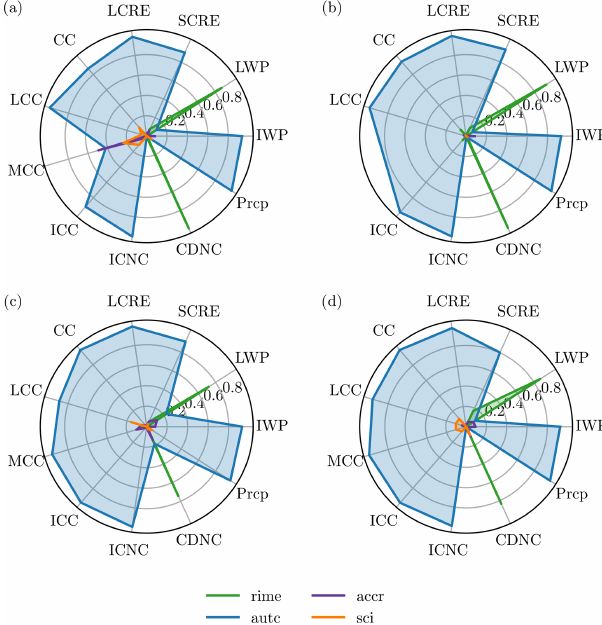
Figure C2. Same as Fig. 12 but for the total sensitivity